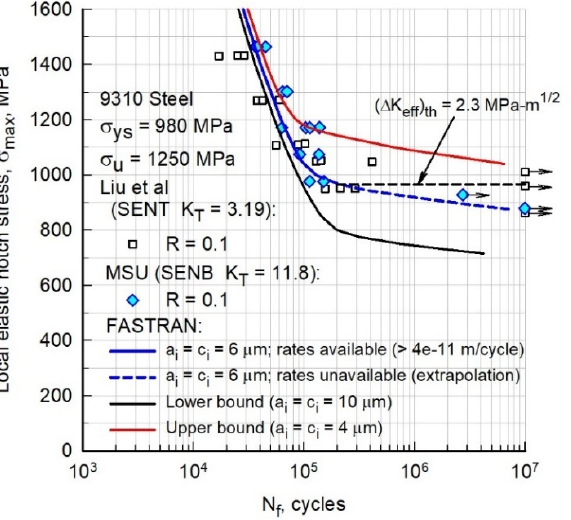
Figure 10. Measured and calculated stress-life behavior under constant-amplitude loading.